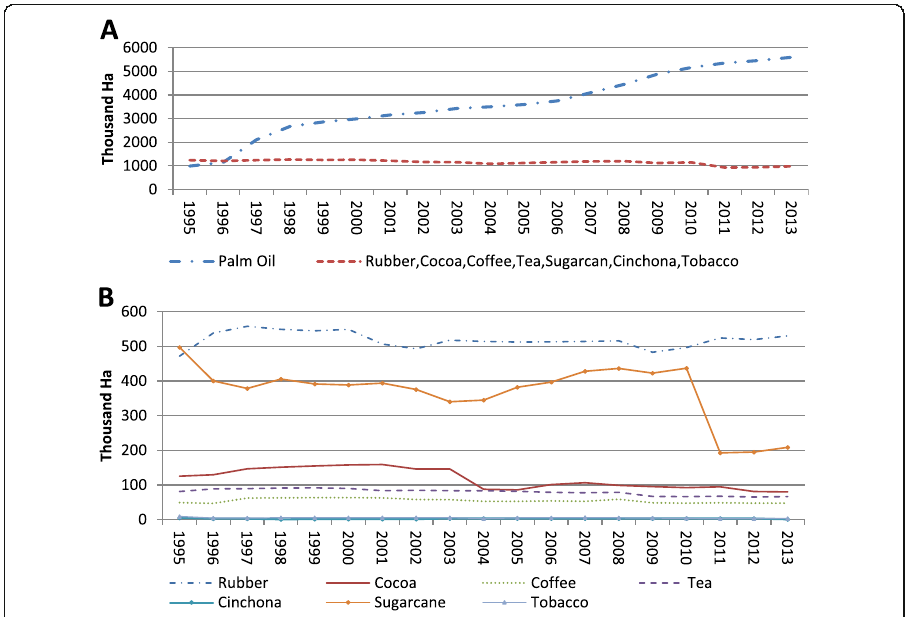
Fig. 1 Harvested area under palm oil and the main agricultural crops in Indonesia. Data Source: Department of Statistics, Indonesia (2016)